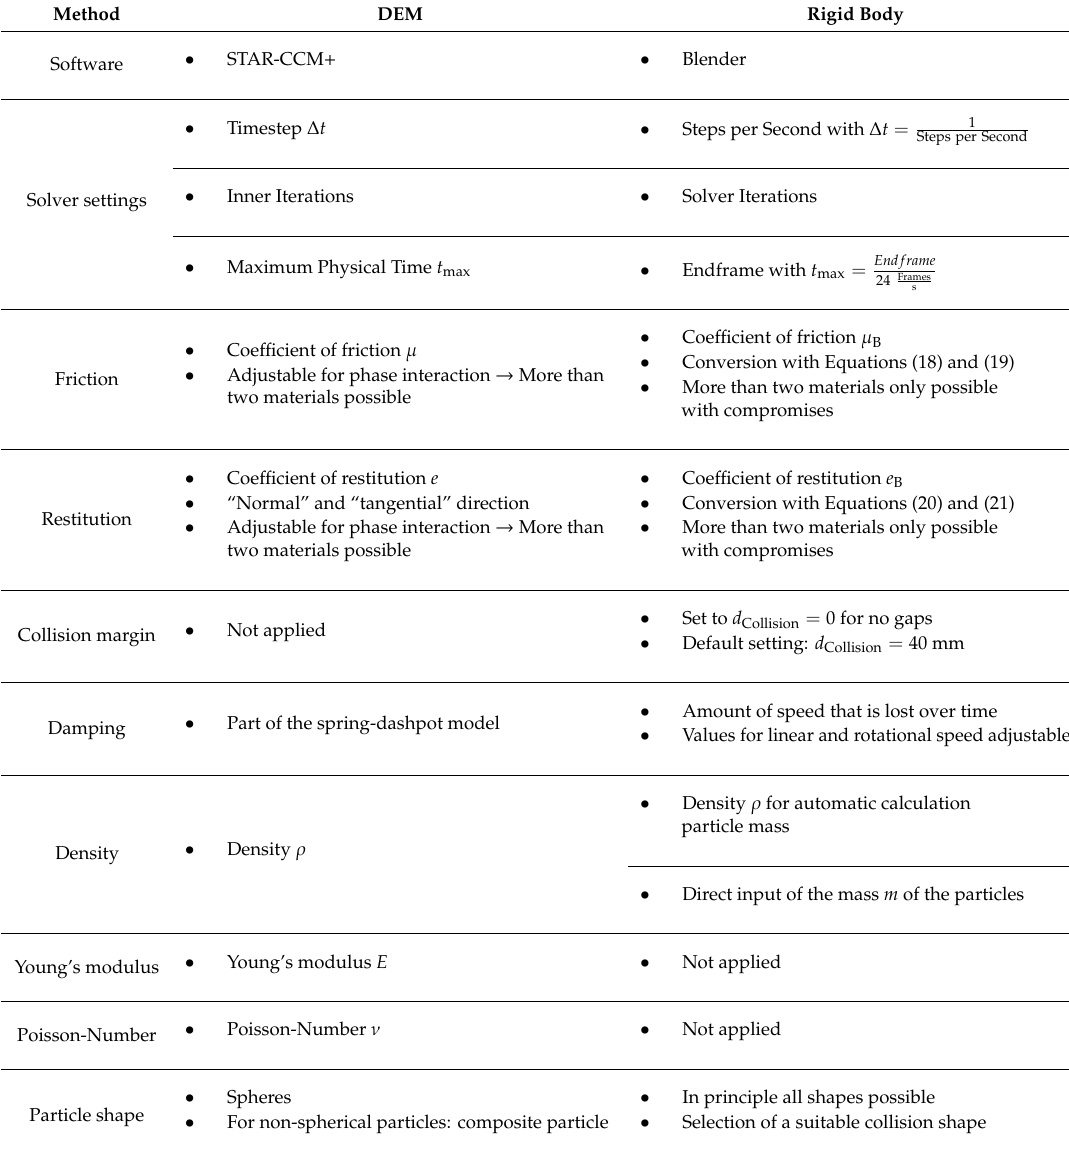
Table 3. Comparison of DEM and rigid body settings.